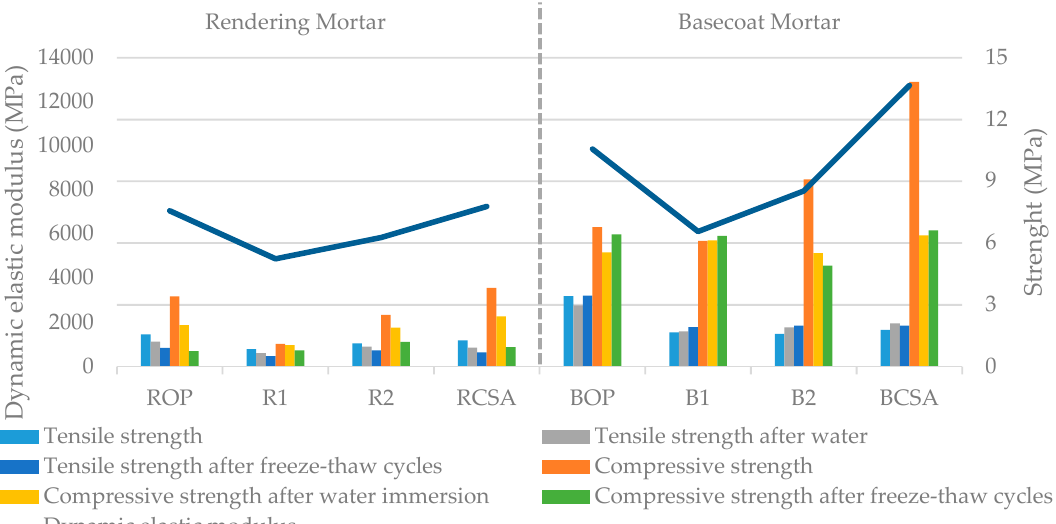
Figure 4. Compressive strength, tensile strength and dynamic elastic modulus, after standard conditions, water immersion and freeze-thaw cycles of rendering and basecoat mortar.